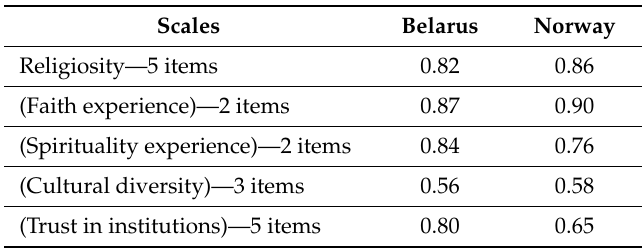
Table 5. The reliability of the scales (Cronbach’s alpha).